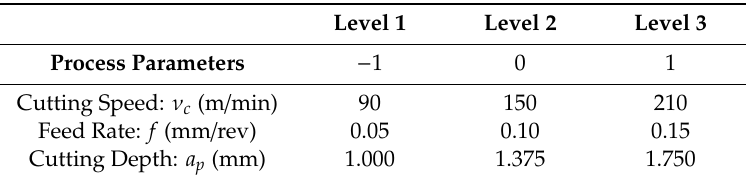
Table 3. Experimental factors and levels.